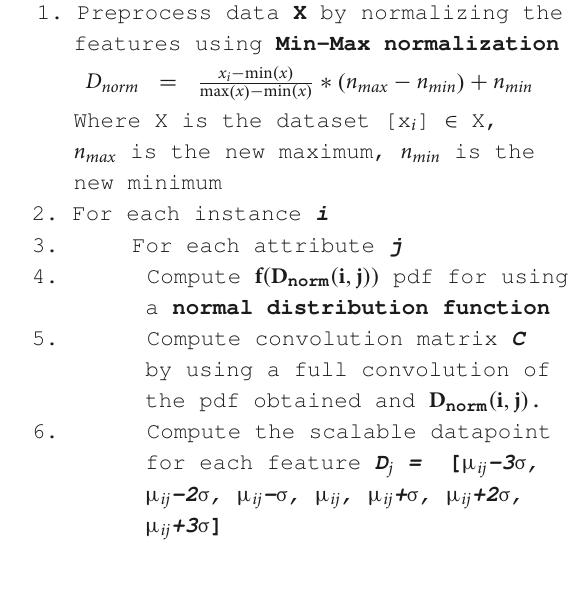
Algorithm 1: MF-granular input encoding using a Gaussian Kernel based convolution.